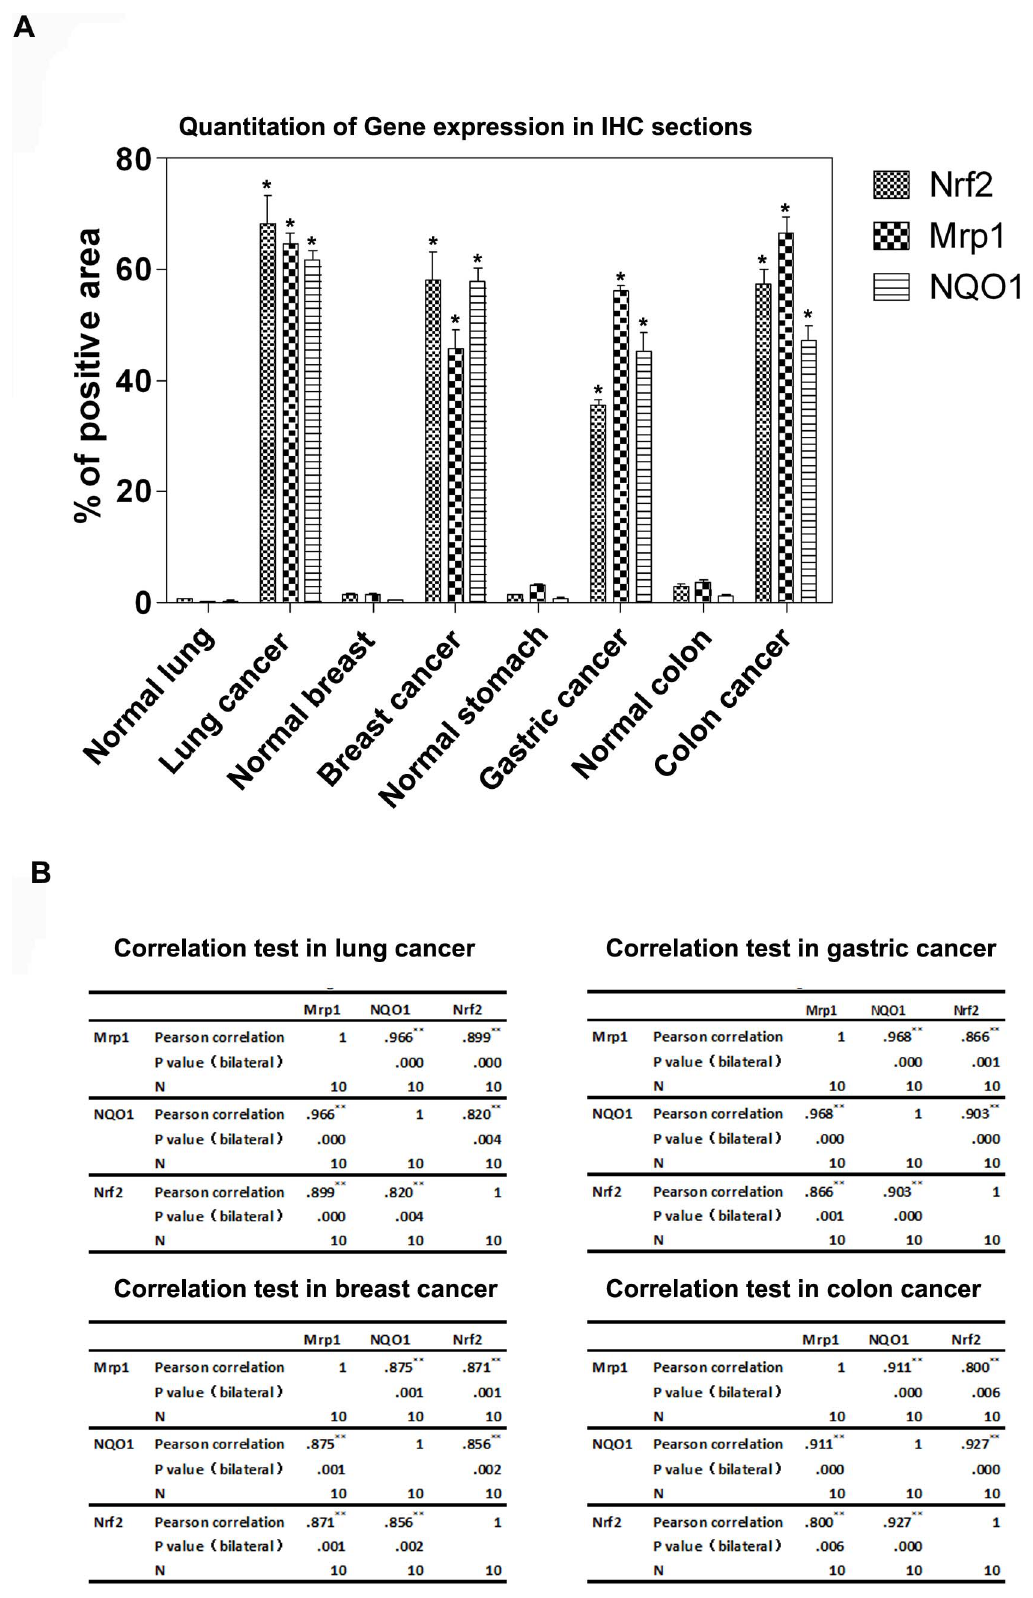
Figure 7. Statistical analysis of IHC data using i-Solution software. Five random visual fields were selected in each section and then were taken pictures of by camera. The pictures were analyzed by i-Solution software, and the positive area and the whole area of each picture were calculated. The protein level of Nrf2, Mrp1 and NQO1 was expressed as ratio of positive area to whole area. (A) The different expressing levels of Nrf2,